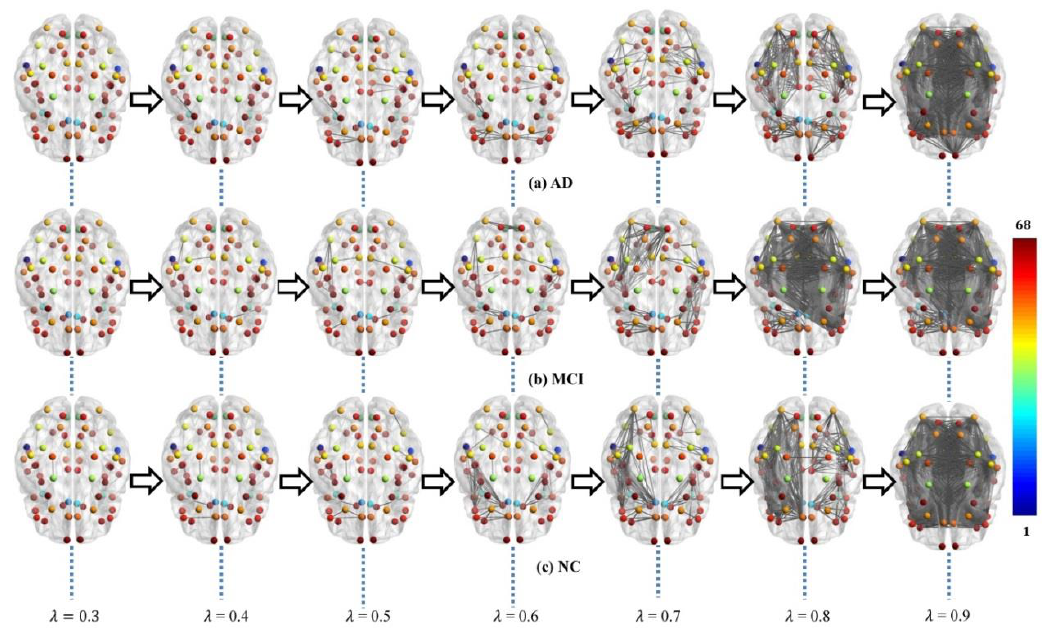
Figure 2. Multiscale WM networks of the three groups, AD ( a ), MCI ( b ), and NC ( c ), at some filtrations where color bar shows the ROI index. The AD group shows more sparse connections (i.e., more segregated connected components) comparing to controls when the filtration values are smaller ( λ ≤ 0.8).